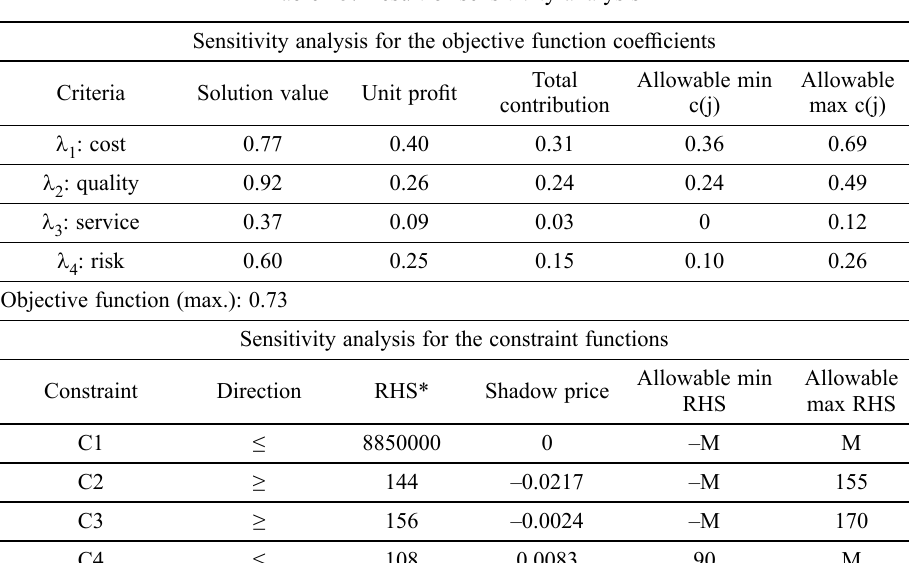
Table 15. Result of sensitivity